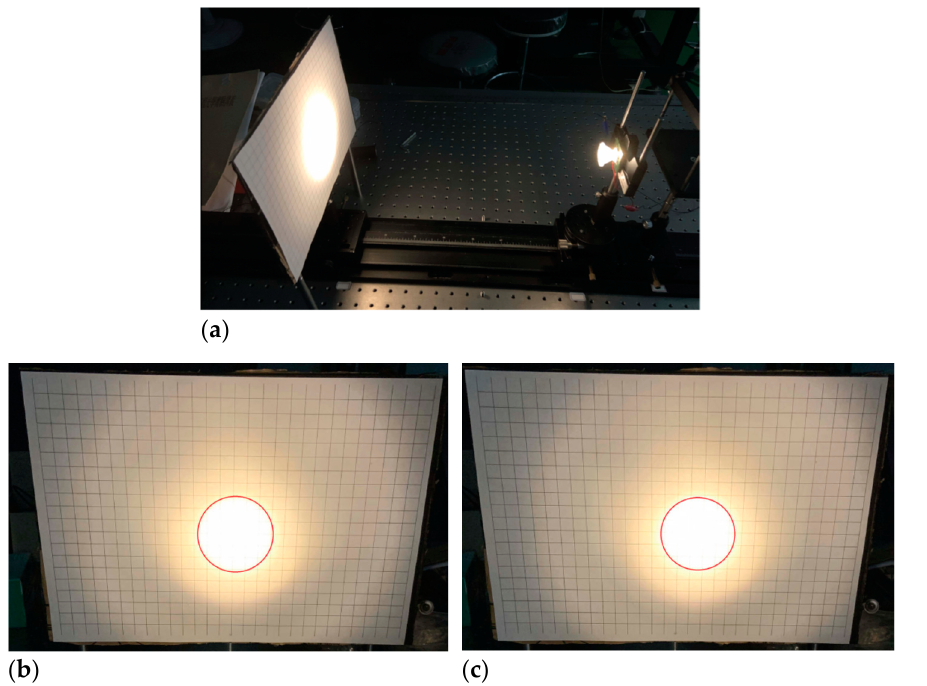
Figure 3. Photos of ( a ) the measurement architecture, ( b ) the irradiance distribution without external error, and ( c ) the irradiance distribution with the external angle error of 2° for the experimental results of the LPL unit.